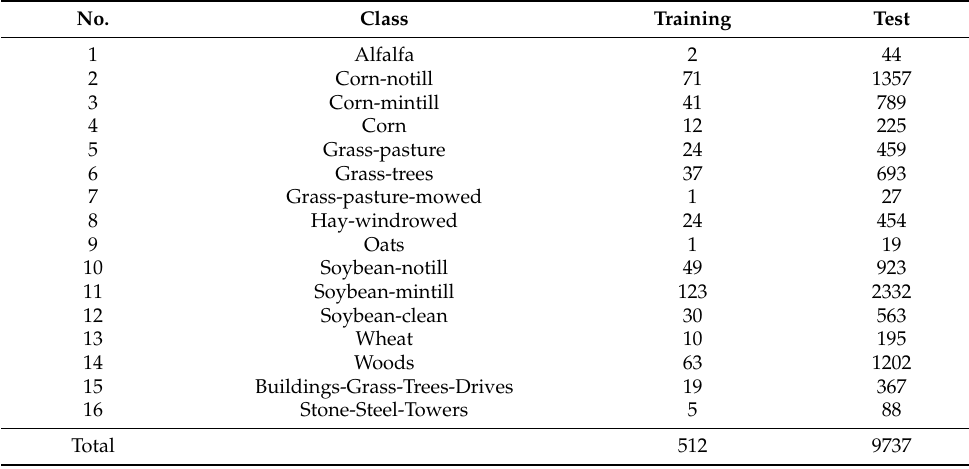
Table 1. Training and testing data in the Indian Pines data